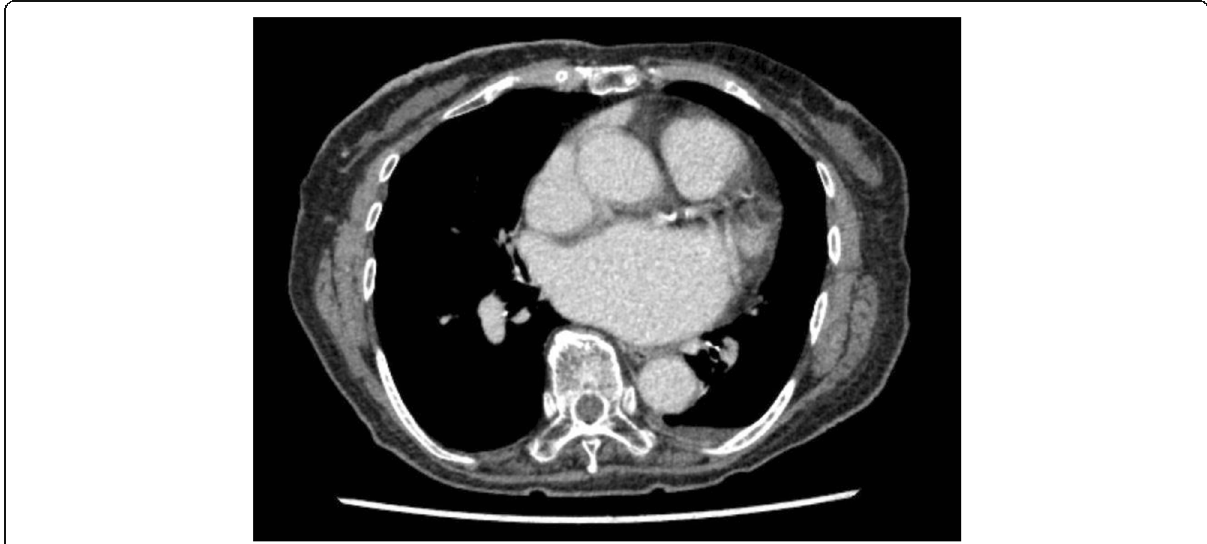
Fig. 2 Computed tomography. The tumor was only on the surface of the breast without any underlying tumor